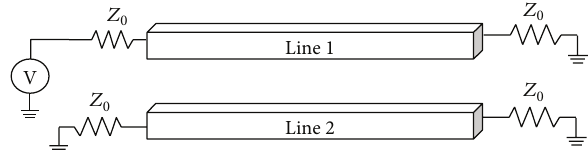
Figure 1: Model of the parallel lines on a printed circuit